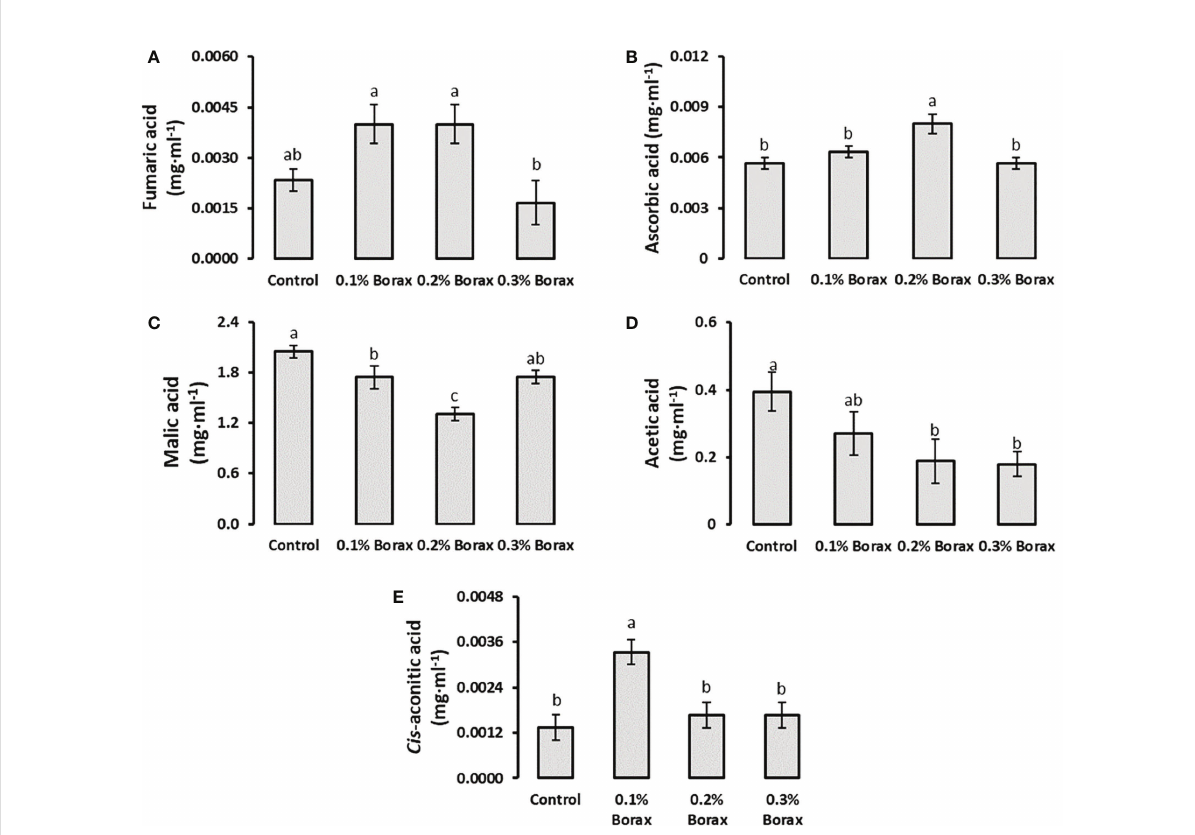
FIGURE 4 Effect of foliar application of B on the level of organic acids i.e., fumaric acid (A) , ascorbic acid (B) , malic acid Ali et al.,, acetic acid (D) , and cis - aconitic acid (E) in loquat fruits. Same letters indicate non-signi fi cant difference among treatments according to Fisher ’ s least signi fi cant difference (LSD) test, when p ≤ 0.05 . Vertical bars indicate mean ± standard error (n=4, 4-block RCBD